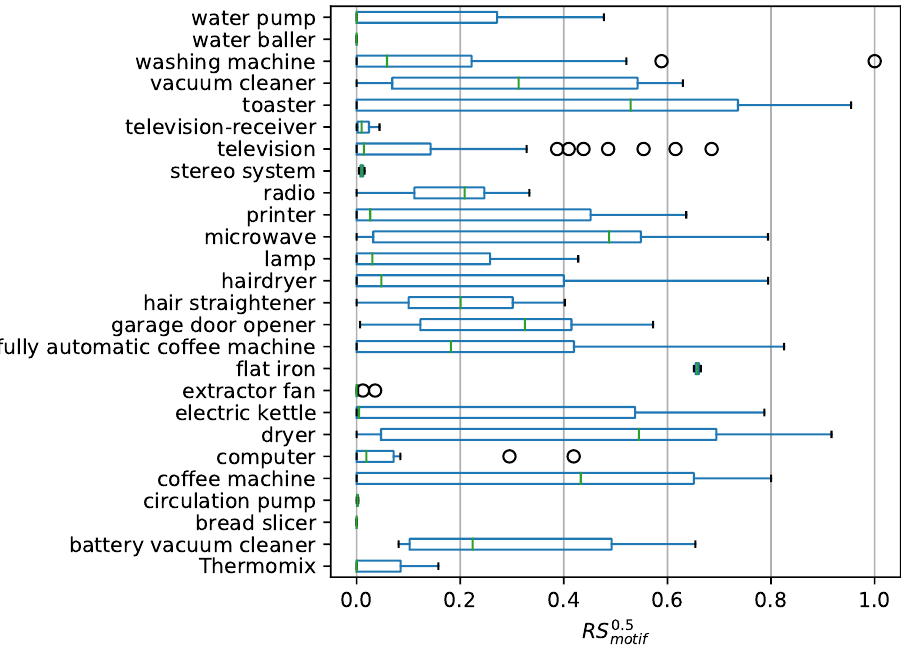
Figure 7. Box plot on RS 0.5 for all extracted motifs motif n ∈ M grouped by motif n